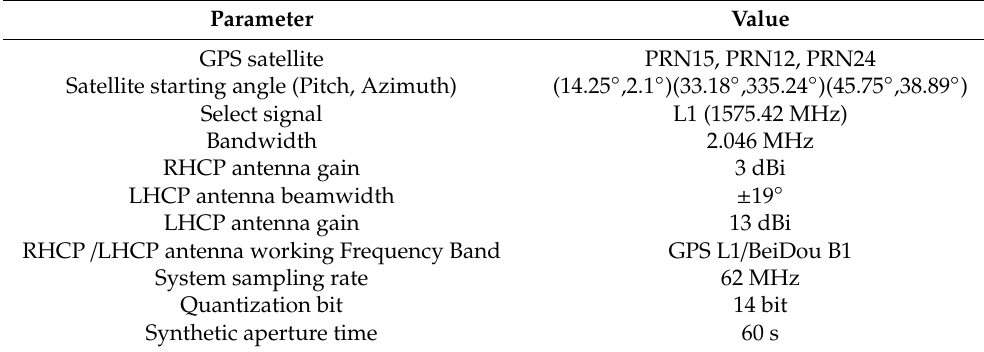
Table 4. Parameters used in the experiment.